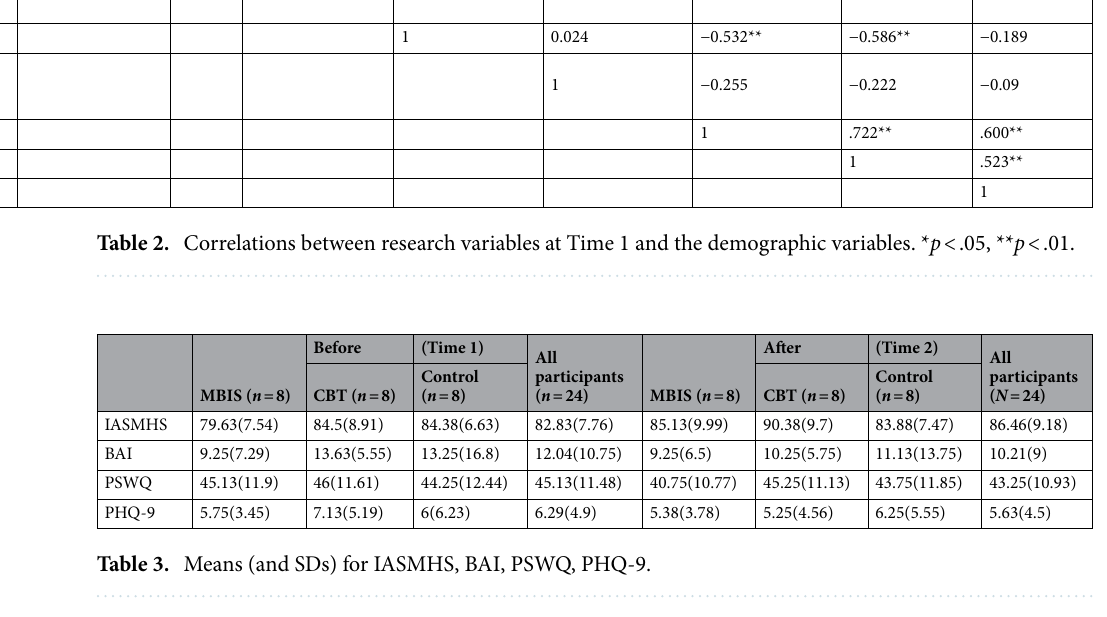
Table 3. Means (and SDs) for IASMHS, BAI, PSWQ, PHQ-9.